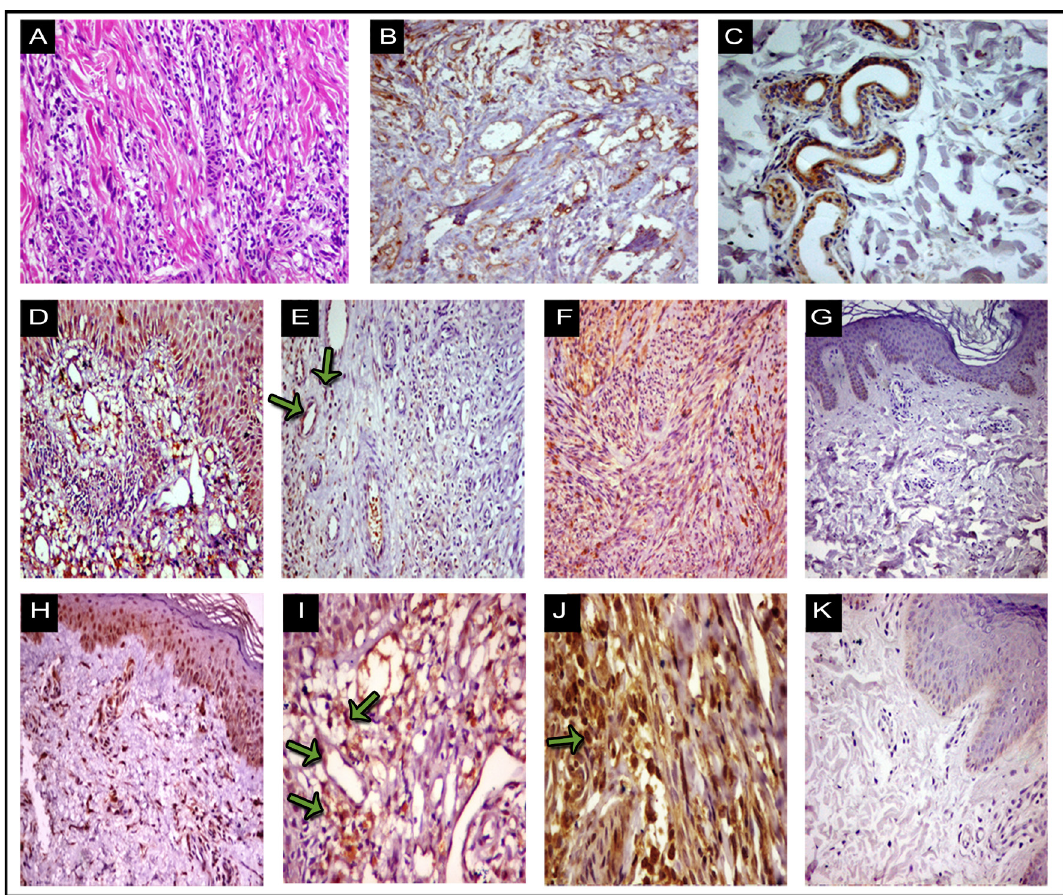
Figure 1. Representative images of Kaposi’s sarcoma (KS). Lesions with hematoxylin and eosin stain ( A ), CD34 ( B ), human β defensin (HBD)-3 ( D-G ) and cathelicidin LL-37 ( C , H-K ). Immunohistochemistry for CD34 ( B ) is strongly positive in KS lesions. HBD-3 and cathelicidin LL-37 immunoreactivity is less intense in plaque ( E , I ; respectively) than in nodular lesions ( F , J ; respectively). Positive immunohistochemical staining of HBD-3 and LL-37 in endothelial cells and spindle shaped cells are indicated by arrows. Positive epidermal staining for HBD-3 ( D ) and cathelicidin LL-37 ( H ) can be appreciated. Positive internal control for cathelicidin LL-37 in sweat glands ( C ) and inflammatory cells ( E , I ) for HBD-3 and cathelicidin LL-37; respectively are seen. Healthy skin as negative control for HBD-3 and cathelicidin LL-37 are seen in ( G , K ). Original magnification: ( A , B , C , D , E , F , H , K ) X 200; ( G ) X 100; ( I , J ) X 400.